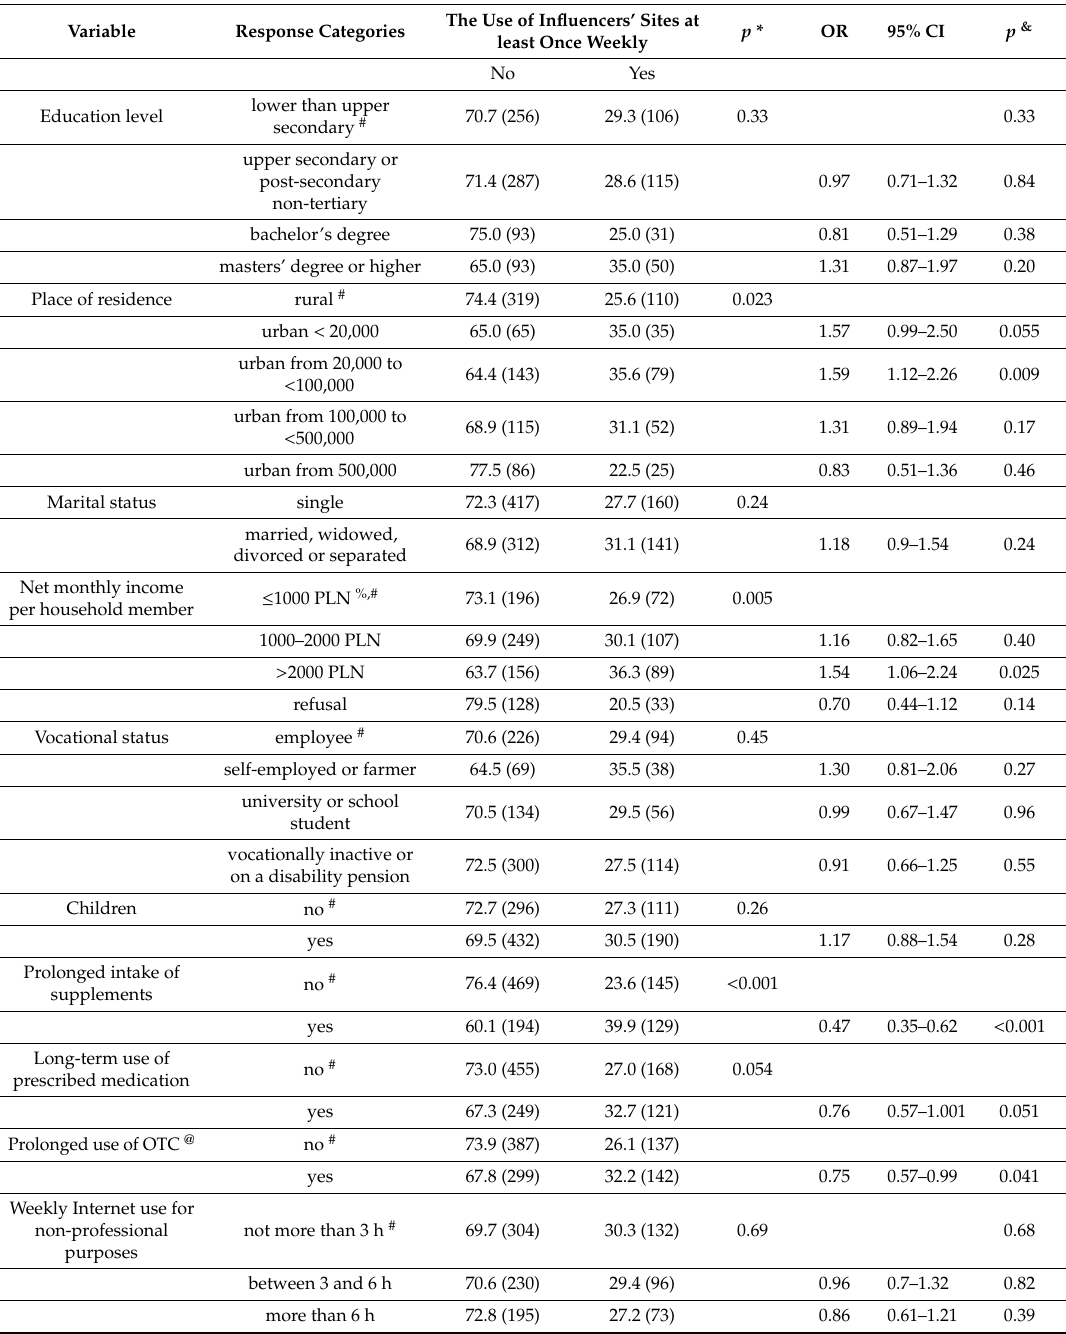
Table 3. Factors related to the use of fitness influencers’